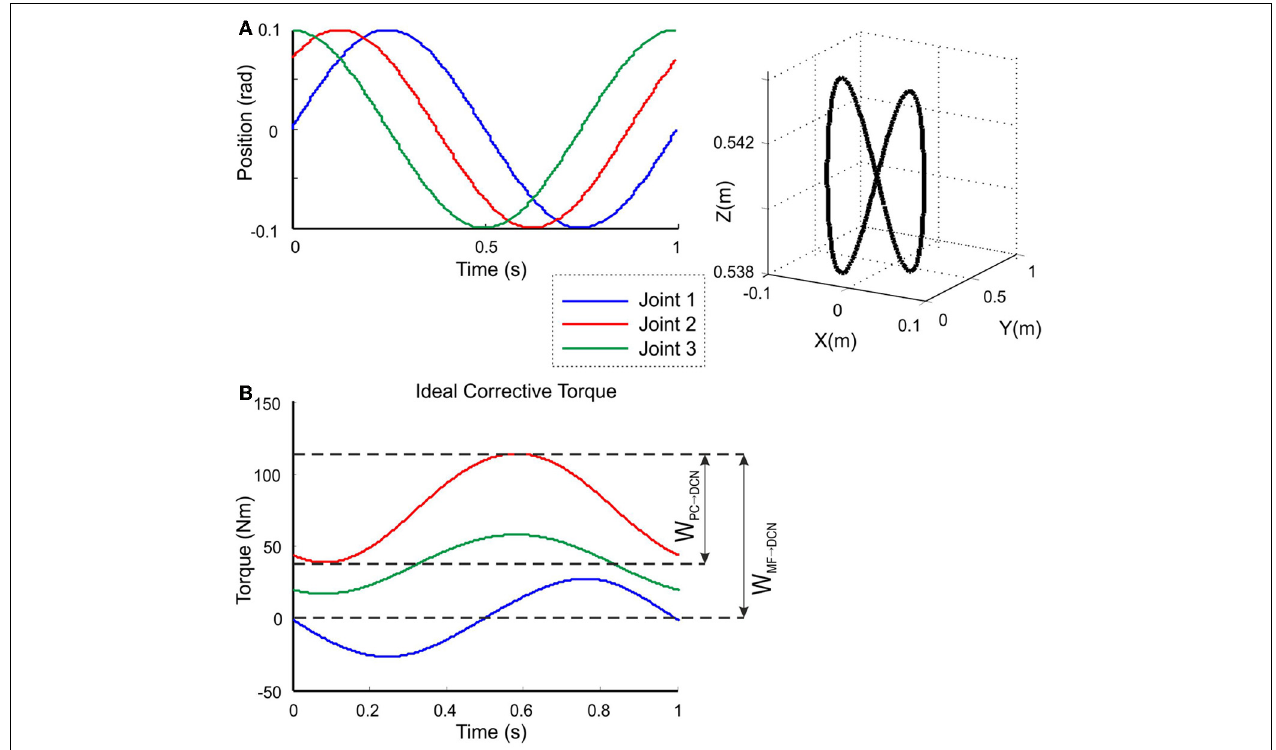
FIGURE 5 | Calculation of the target trajectory. Three-joint periodic trajectory defining an 8-shape movement [redrawn with permission from Luque et al. (2011c)] (A) Angular coordinates of each joint of the LWR (left) , and 3D view of the robot end-effector trajectory in Cartesian coordinates (right) . This 8-shape trajectory demands a movement difficult enough to allow robot arm dynamics to be revealed in fast movements (Hoffmann et al.,